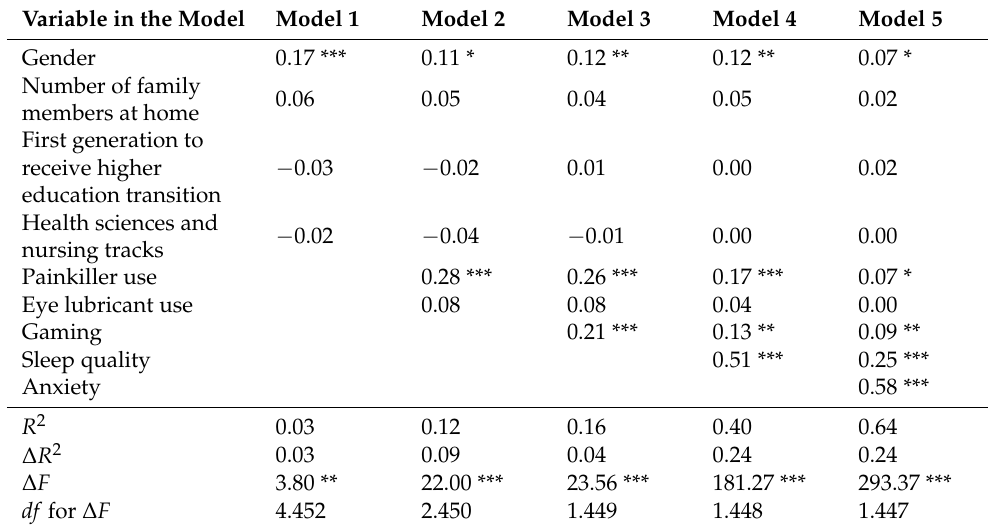
Table 5. Hierarchical multiple linear regression for depression ( n = 457).